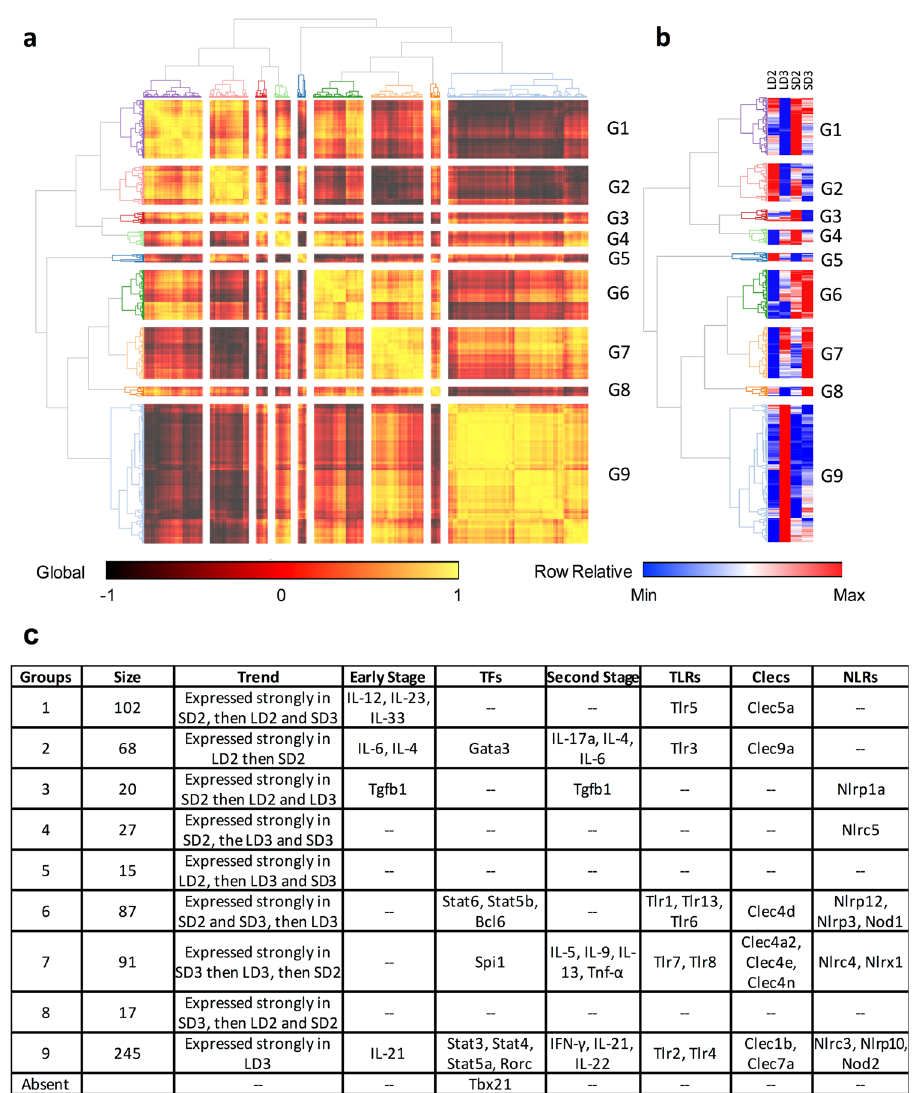
Figure 2. Transcript profiles of immunologically relevant murine genes. ( a ) hierarchical clustering of murine immunological relevant genes (IRGs) based on transcript expression during steroid and chemotherapeutic models of invasive pulmonary aspergillosis on day 2 and 3 post inoculation. ( b ) relative transcript expression for a given IRG. ( c ) Summary table of identified genes that cluster together based on expression. Identification of notable early stage cytokines, later stage cytokines, and transcription factors associated with T-cell differentiation, toll-like receptors ( Tlrs ), C-type lectins ( Clecs ), and Nod-like receptors ( Nlrs ) amongst clustered IRG groupings. Steroid Model, S; Chemotherapeutic Model, L; Day 2, D2; Day 3,